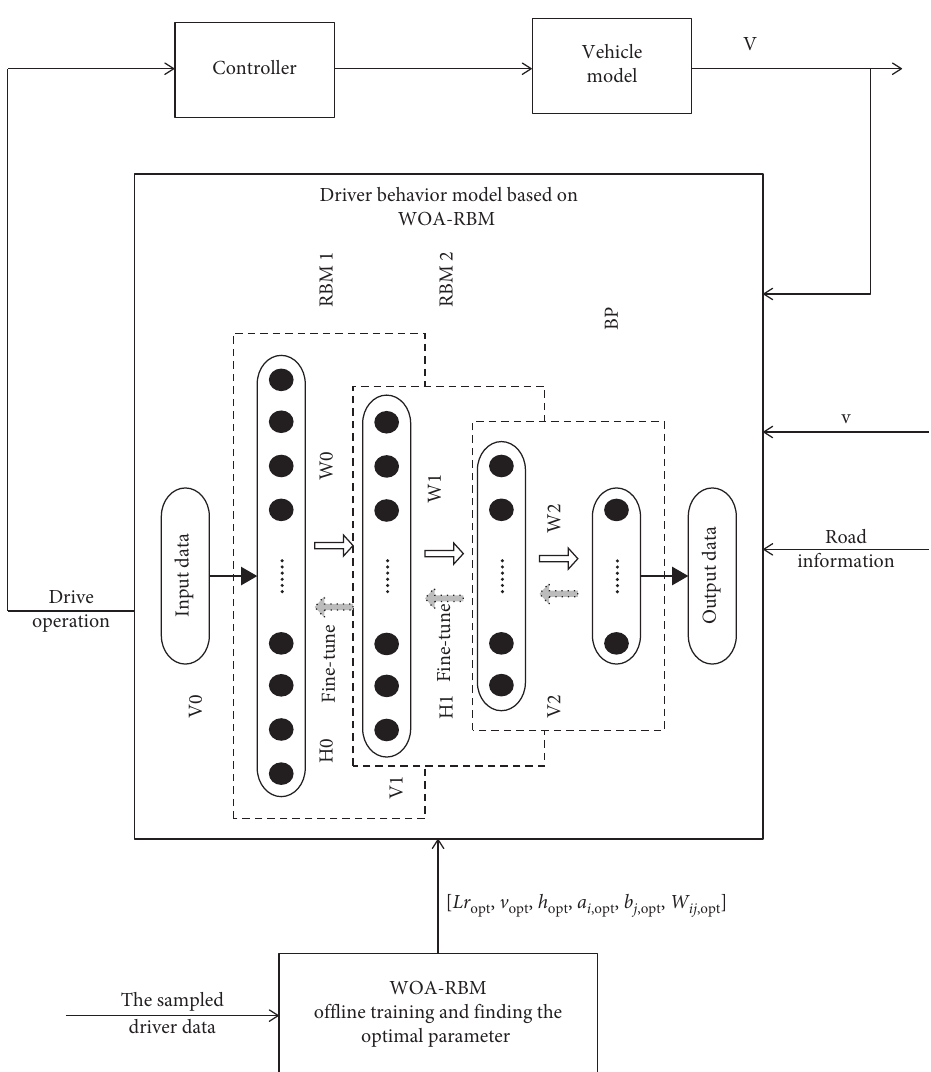
Figure 8: The structure of driver behavior model based on WOA-RBM.